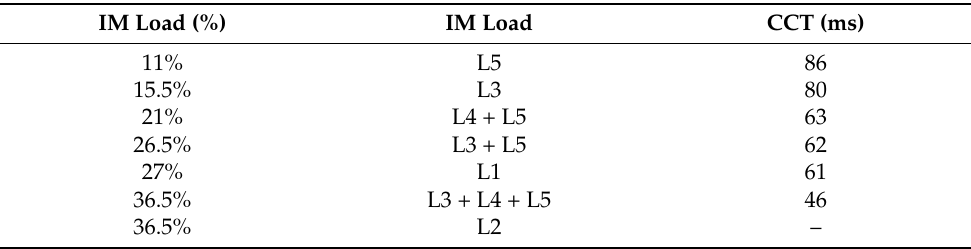
Table 4. Network fault critical clearance time vs. IM load